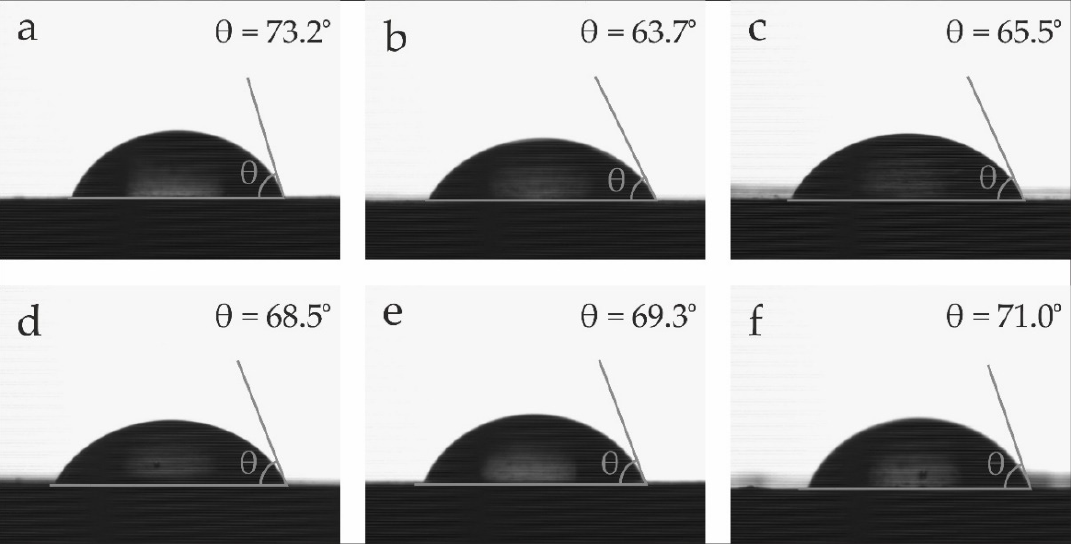
Figure 7. Water contact angle ( θ w ) of the samples: ( a ) neat BioPBSA; ( b ) BioPBSA/HEMP; ( c ) BioPBSA/HEMP/7.5DBI; ( d ) BioPBSA/HEMP/15DBI; ( e ) BioPBSA/HEMP/PBSA- g -IA; ( f ) BioPBSA/HEMP/PBSA- g -MA.